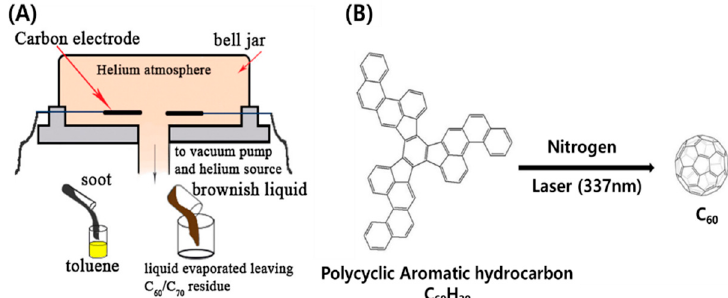
Figure 12. Schematic of fullerene synthesis methods: ( A ) Huffman–Krätschmer method based on evaporation of graphite. Reproduced with permission from [126] Copyright © 2020 Elsevier Ltd. ( B ) Synthetic route to C 60 H 30 (PAH) and its laser ‐ induced conversion into C 60. Reproduced with permission from [128], Copyright @ 2001 The American Association for the Advancement of Science.